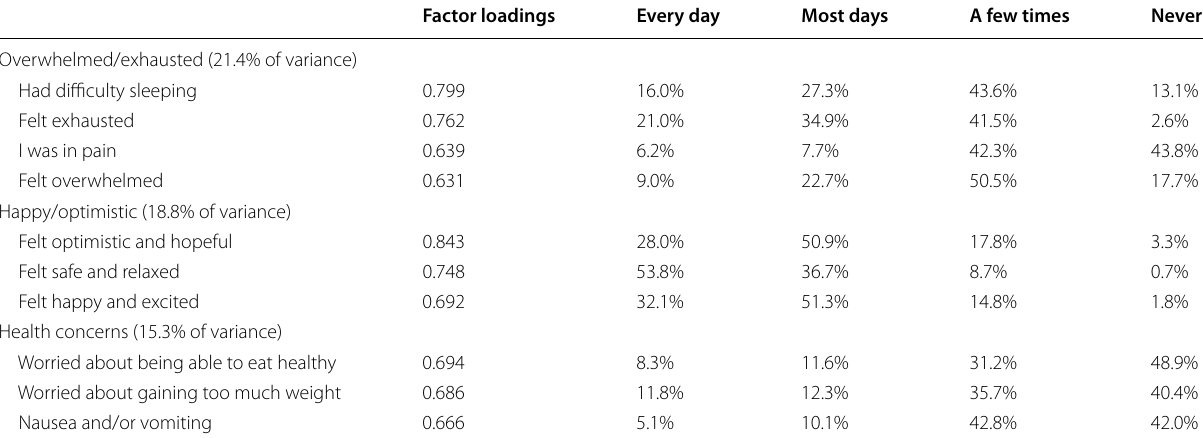
Table 2 Data and results for the scores derived by principal component analysis